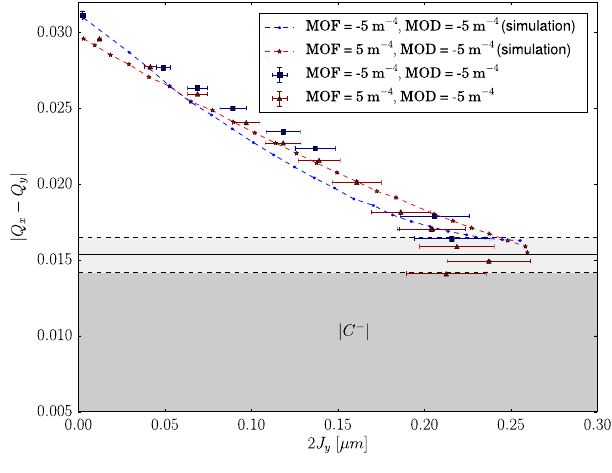
FIG. 2. The difference between the fractional horizontal and vertical tune as a function of vertical action for driven oscil- lations. The excitation was done using the ac dipole and the settings of the octupoles were: MOF ¼ − 5 m − 4 , MOD ¼ − 5 m − 4 and MOF ¼ 5 m − 4 , MOD ¼ − 5 m − 4 . The natural tunes were Q x ¼ 0 . 28 and Q y ¼ 0 . 31 and the drive tunes were Q x;D ¼ ¼ 0 . 32 . The dark gray area shows the linear j C − j 0 . 268 and Q y;D and the light gray area show the uncertainty of the measured